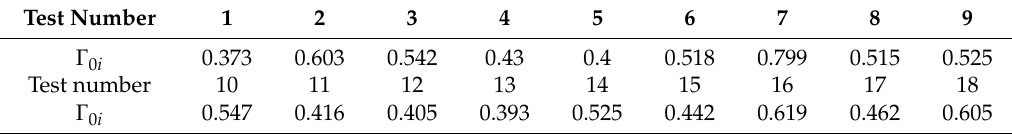
Table 10. The grey relational grade Γ 0 i for each objective sequence ( x i (1), x i (2), x i (3)) in Table 8.